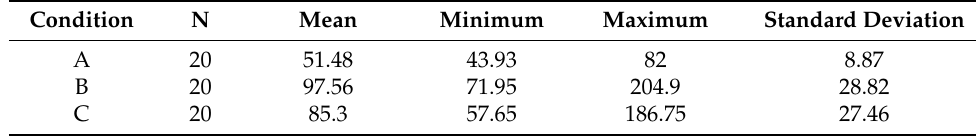
Table 5. Descriptive statistics for the FL travel time in Condition A, B, and